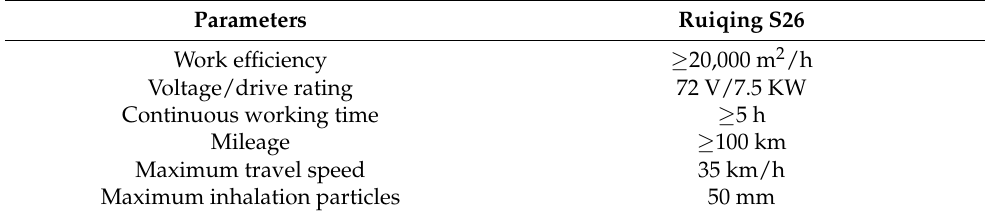
Table 3. S26 technical